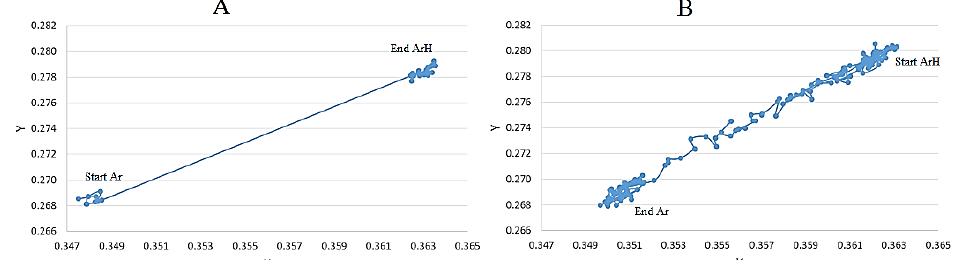
Figure 10. ( A ) The chromaticity colour functions, x and y , are plotted during the transition from Ar to ArH as the deposition of the S1 samples is undertaken. An instant jump in the index values is observed. ( B ) The switch to the Ar gas from the ArH during the S5 sample deposition demonstrates a gradual chaotic variation of the index values is observed, which is in an indication of unstable plasma emissions.